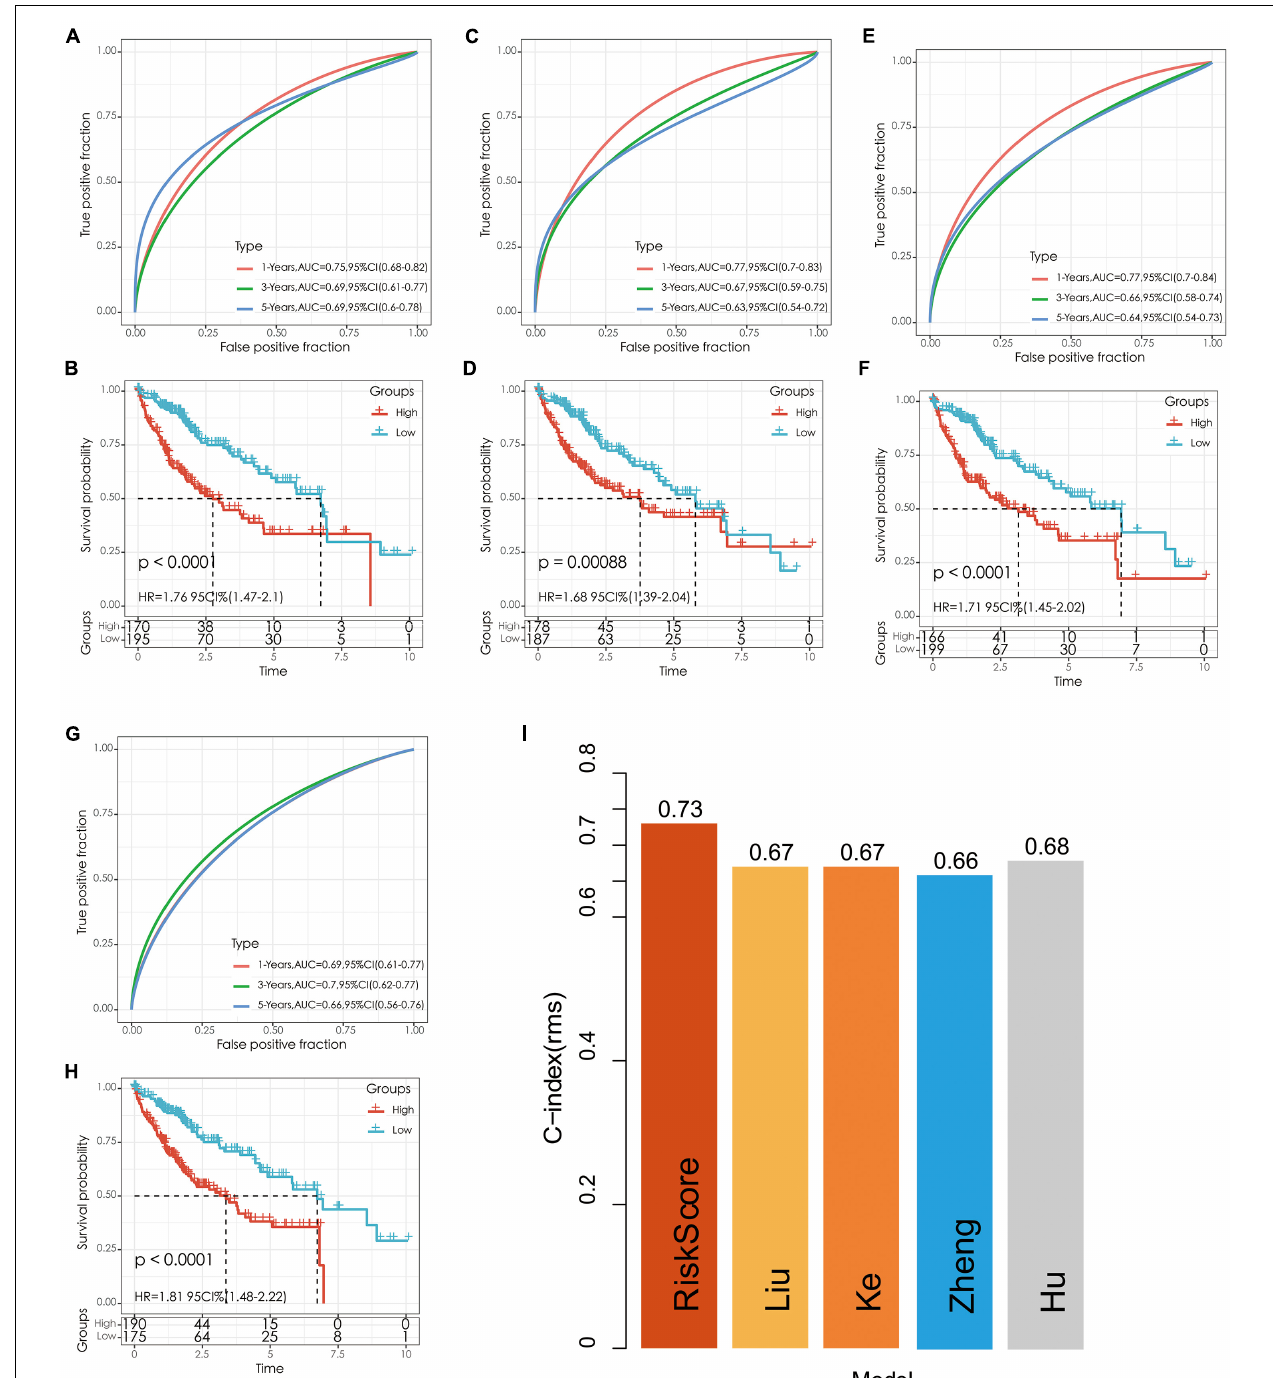
FIGURE 10 | (A,B) The ROC curve of Hu’s risk model and the KM curve of high-risk and low-risk groups. (C,D) The ROC curve of Liu’s risk model and the KM curve of high-risk and low-risk groups. (E,F) The ROC curve of Ke’s risk model and the KM curve of high-risk and low-risk groups. (G,H) The ROC curve of Zheng’s risk model and the KM curve of high-risk and low-risk groups. (I) C-index comparison of different prognostic risk models.